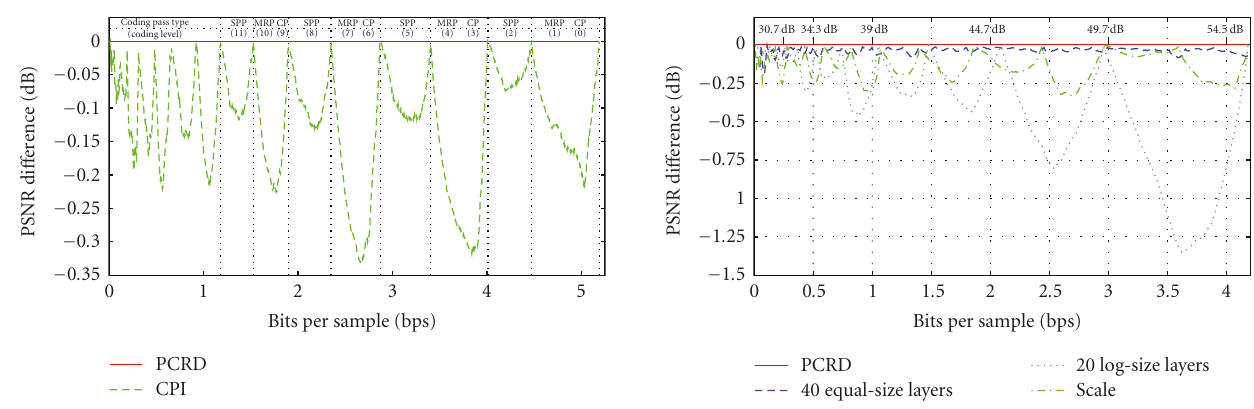
Figure 2: Coding performance evaluation between PCRD and CPI for the cafeteria image. The straight red line depicts the optimal coding performance achieved by PCRD; the CPI line depicts the di ff erence between PCRD and CPI at 2000 equally distributed target bitrates from 0.001 to 5.1 bps.